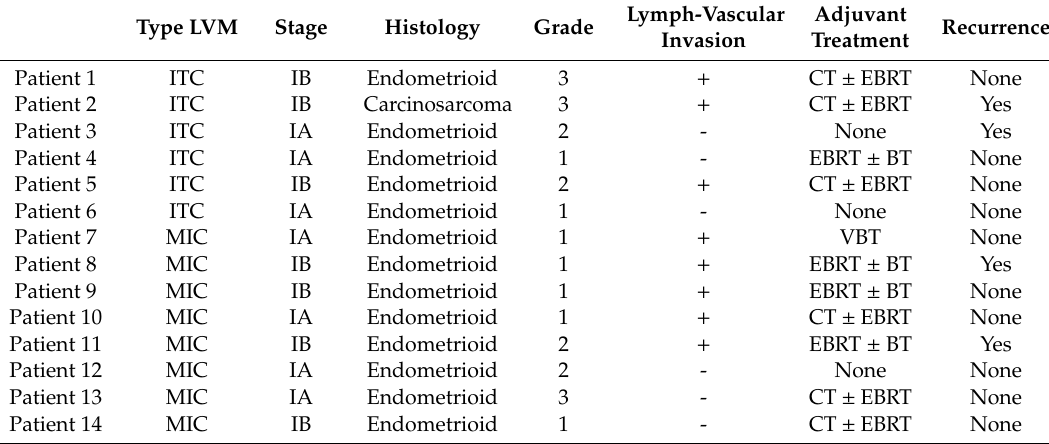
Figure 2. Overall survival by nodal status for the cohort with nodal staging. Significant differences were observed between groups in 5-year OS ( p < 0.001). Table 4. Characteristics of patients with LVM nodal